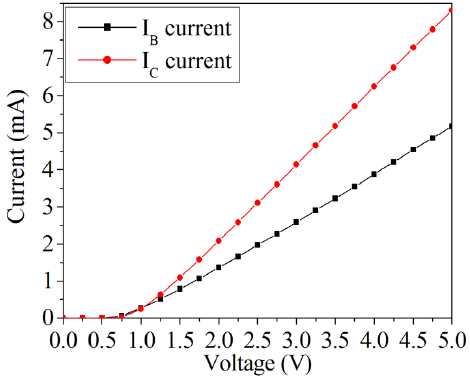
Figure 11. I-V characteristic of the